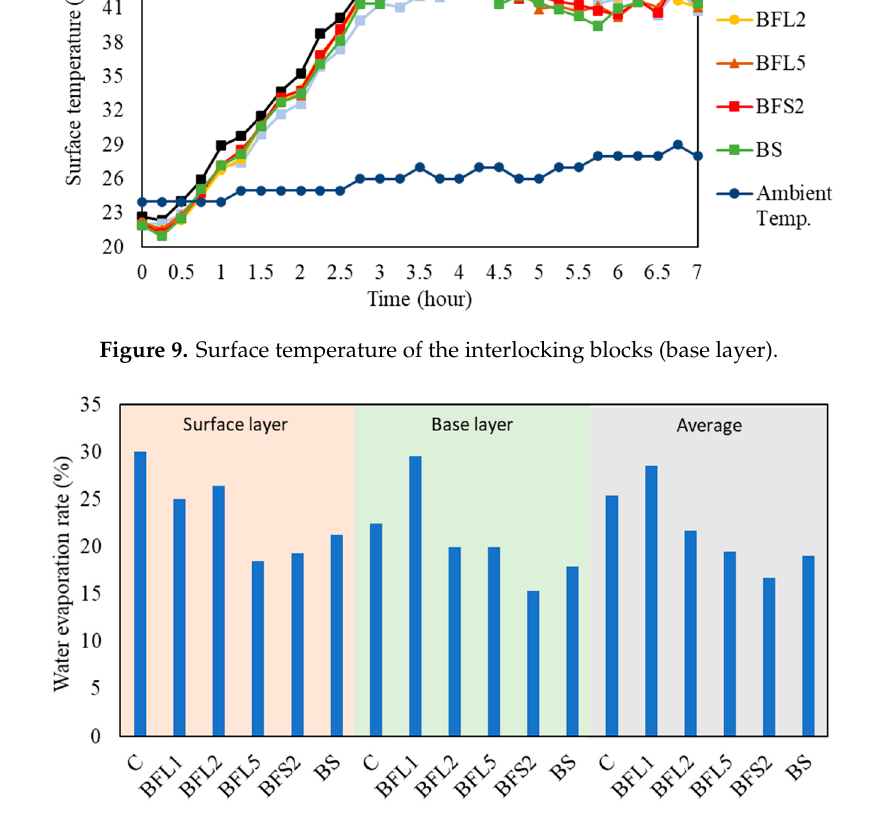
Figure 10. Water evaporation rate.